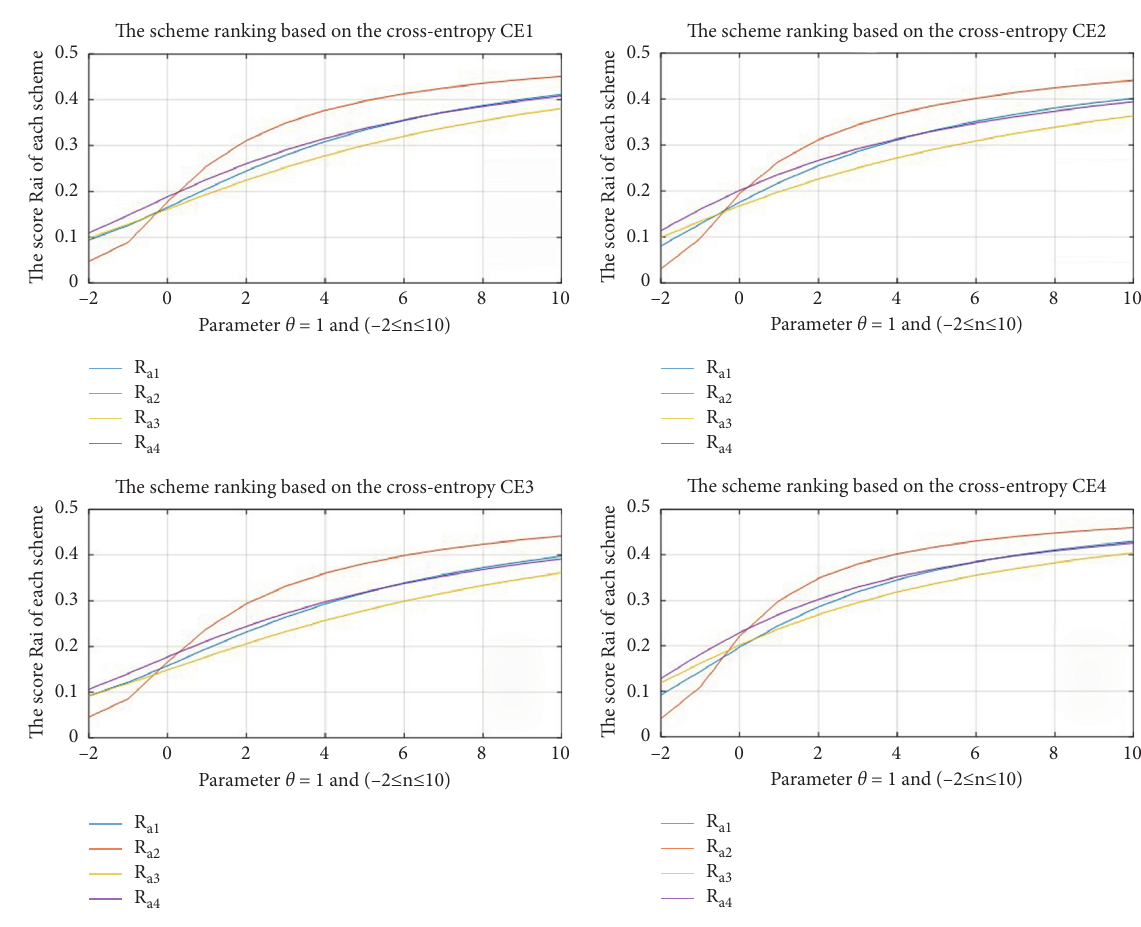
Figure 6: Ranking score of each alternative based on parameters θ � 1, − 2 ≤ n ≤